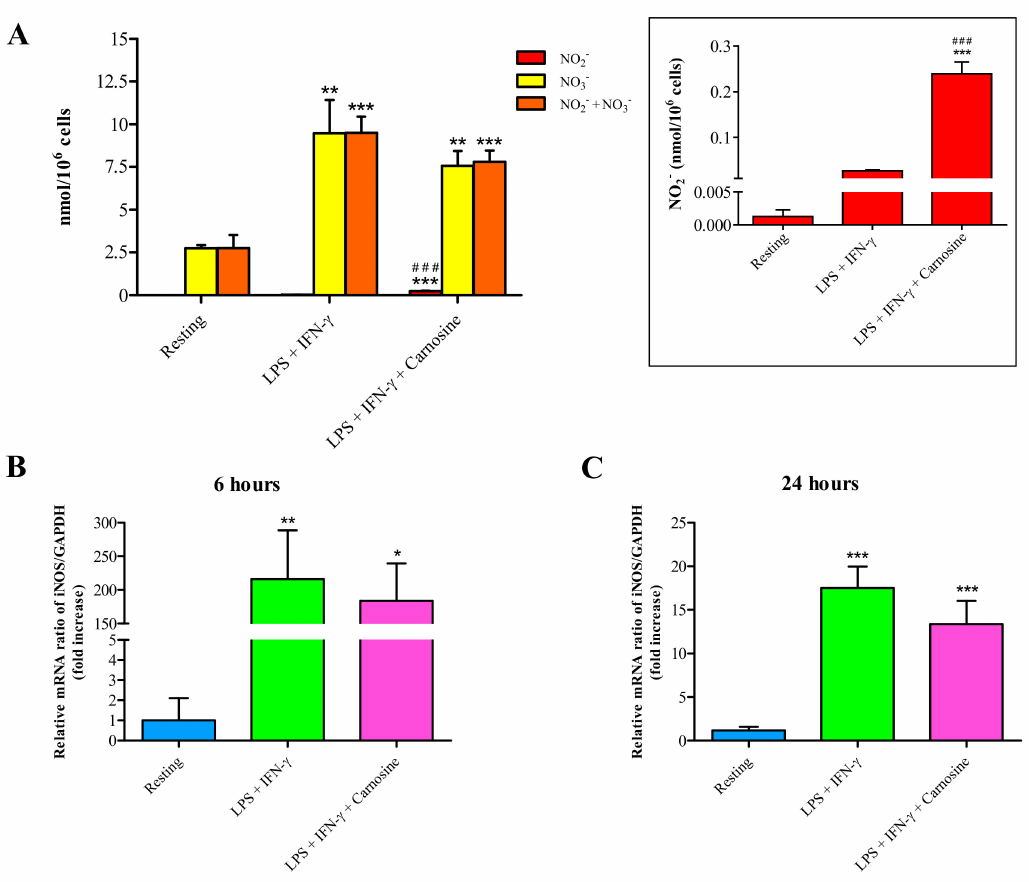
Figure 2. ( A ) Concentrations of NO metabolites (NO 2 − , NO 3 − ,and NO 2 − + NO 3 − ) in resting (control) RAW 264.7 macrophages and in RAW 264.7 macrophages stimulated with LPS (100 ng / mL) + IFN- γ (600 U / mL), in the absence or in the presence of carnosine (20 mM). Values are means ± SD of three to four independent experiments and are expressed as nmol / million cells. Measurement of iNOS gene expression after ( B ) 6 h or ( C ) 24 h in cells treated as aforementioned. The abundance of iNOS mRNA was expressed relative to that of the housekeeping gene GAPDH. Values are means ± SD of three to four independent experiments. * p < 0.05 vs. resting; ** p < 0.01 vs. resting; *** p < 0.001 vs. resting; ### p < 0.001 vs. LPS + IFN- γ